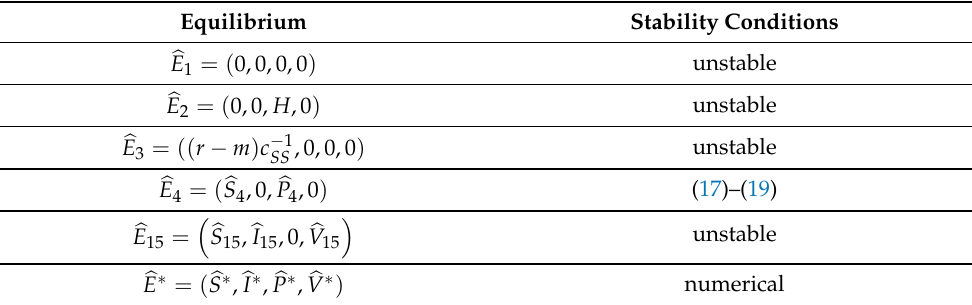
Table 6. Equilibria (cid:98) E k = ( S k , I k , P k , V k ) of (11) and their stability properties.